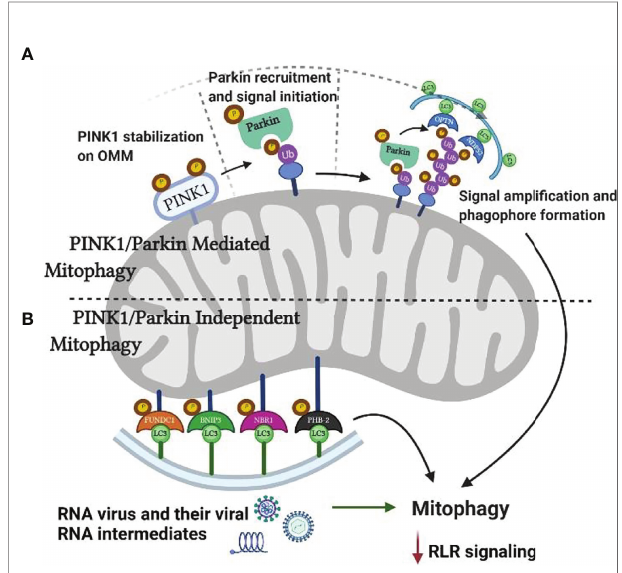
FIGURE 4 | Mitophagy and RNA virus infection. Mitochondria can undergo mitophagy either by PINK1/Parkin dependent or independent pathways. As increased rate of mitophagy reduces RLR mediated antiviral response, RNA viruses and their viral RNA intermediates increase mitophagy by targeting PINK1 and other key